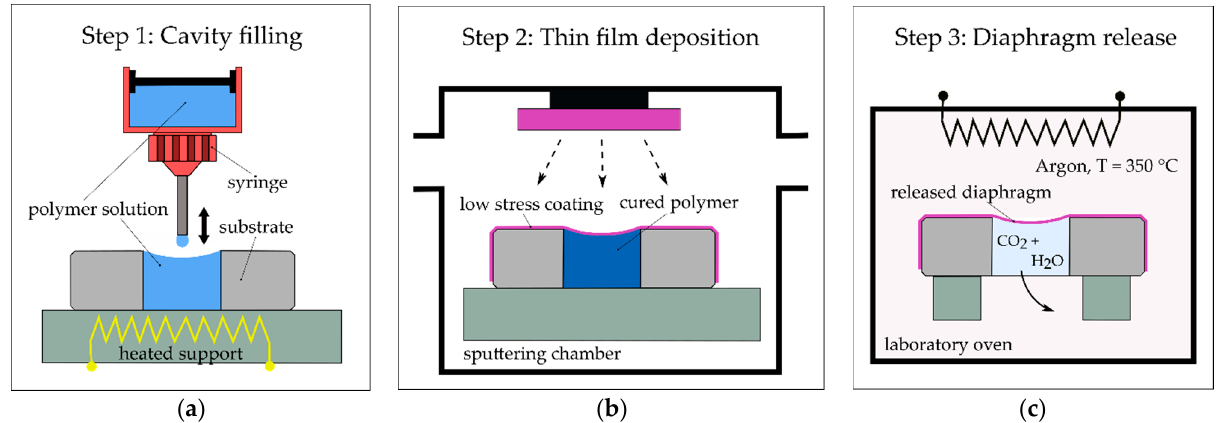
Figure 2. General overview of the diaphragm fabrication process. ( a ) Step 1, filling process: sacrificial material (SM) is added to the substrate; ( b ) Step 2, thin film deposition: metallic coating that represents the diaphragm is deposited on the substrate using chemical vapor deposition; ( c ) Step 3, diaphragm release: the diaphragm is released from the SM during a thermal treatment process.